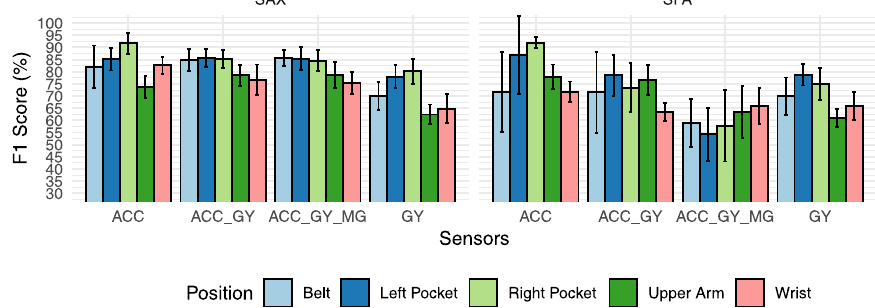
Figure 12. Classification performance at each position of SHOAIB dataset. The discretization method used in this experiment was SAX and SFA, with T = 2.5 s , α = 6, ω =